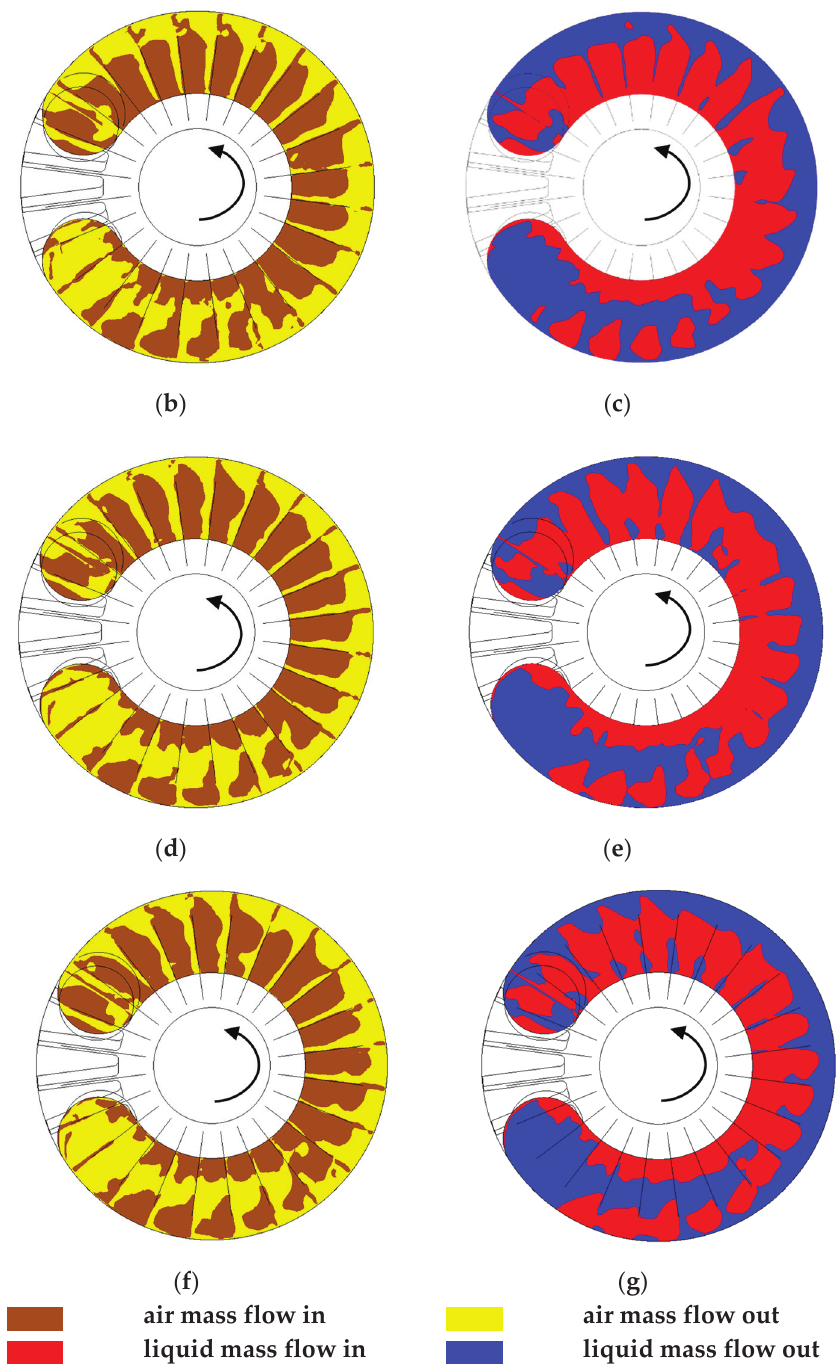
Figure 15. Pressure and velocity streamlines between impeller and side channel. ( a ) single phase, ( b ) IGVF 2% air, ( c ) IGVF 2% liquid, ( d ) IGVF 4% air, ( e ) IGVF 4% liquid, ( f ) IGVF 6% air, ( g ) IGVF 6% liquid.